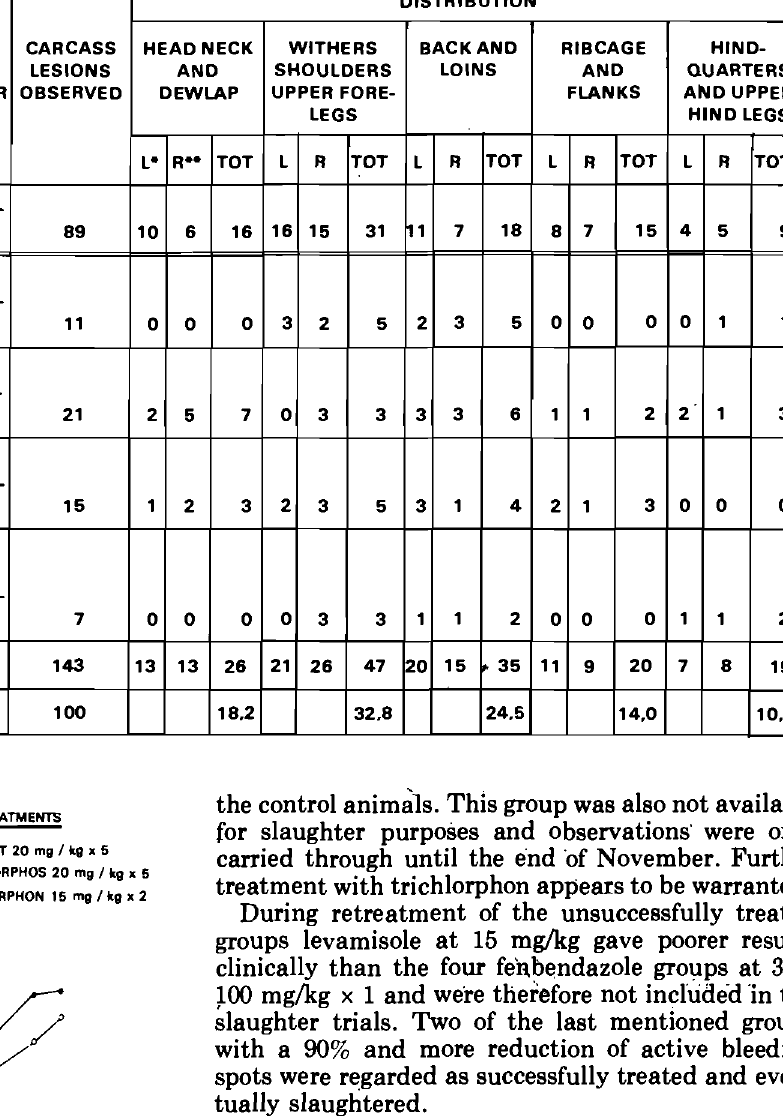
Table 6: FREQUENCY DISTRIBUTION OF CARCASS LESIONS. DISTRIBUTION GROUP ANIMALS PERIOD CARCASS HEAD NECK WITHERS BACK AND RIBCAGE HIND- OF LESIONS AND SHOULDERS LOINS AND QUARTERS DESCRIPTION SLAUGHTERED SLAUGHTER OBSERVED DEWLAP UPPER FORE- FLANKS AND UPPER OR TREATMENT LEGS HIND LEGS R·· L· '. I,INTREATED CONTROLS 9